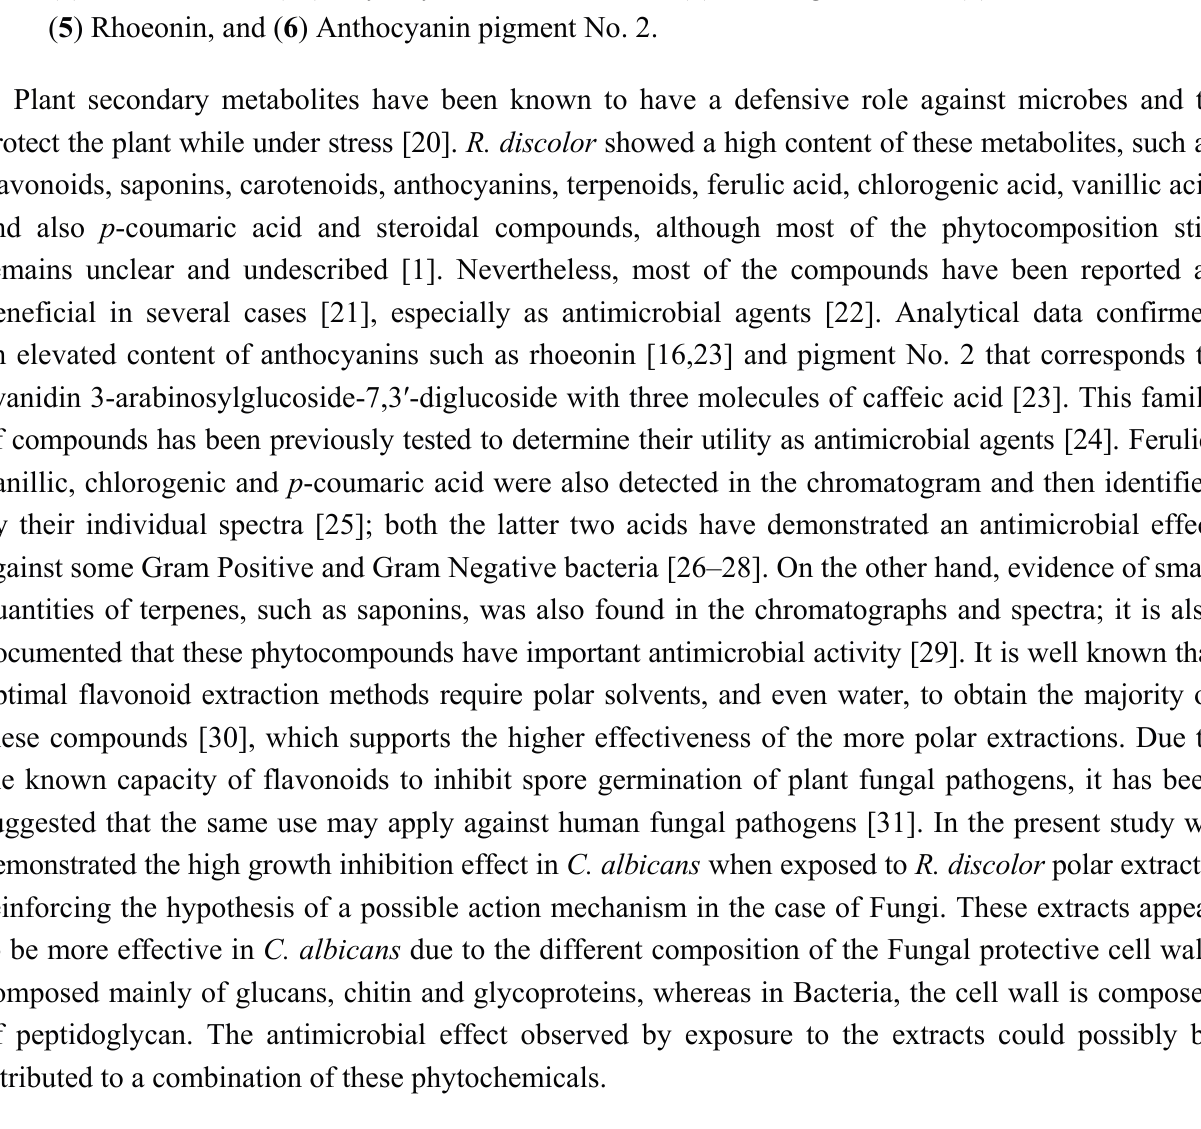
Figure 6. High-Performance liquid chromatography (HPLC) chromatogram at 254 nm of R. discolor extracts: ( A ) Water dry leaves non-boiled extract; ( B ) Water non-dry leaves non-boiled extract; ( C ) Water dry leaves boiled extract; ( D ) Acetone extract; ( E ) Ethyl Acetate extract. Selected chromatographic peaks correspond to the following: ( 1 ) Ferulic